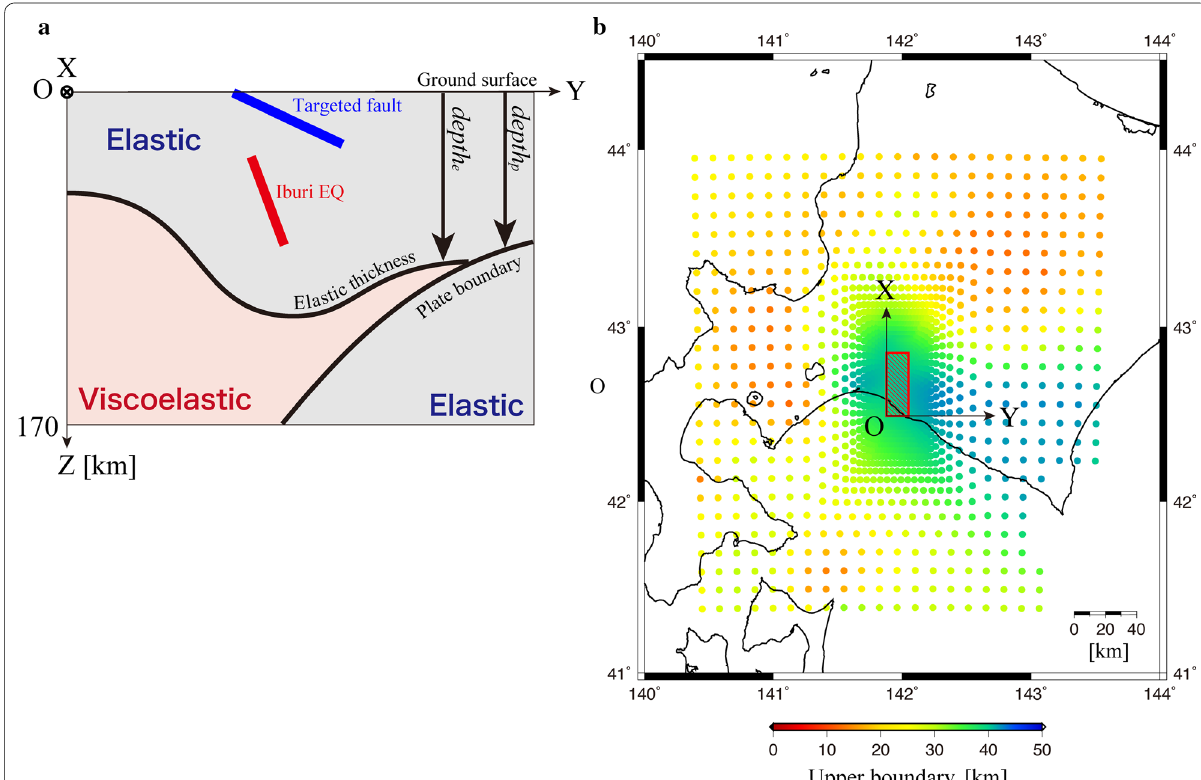
Fig. 4 a Schematic view of the medium with a shallower elastic layer and deeper viscoelastic layer. The viscoelastic layer is limited to depth e ( x ) < Z < min{ depth p ( x ), 170.0 km}. b Distributions of the discretized viscoelastic cells in the X and Y directions, with the depth e indicated by specific colors. Each dot indicates the location of the subfault midpoint, which is distributed in the X and Y directions, although multiple subfaults in the Z direction are set at each location up to min{ depth p ( x ), 170.0 km}. The red rectangle corresponds to the surface projection of the mainshock